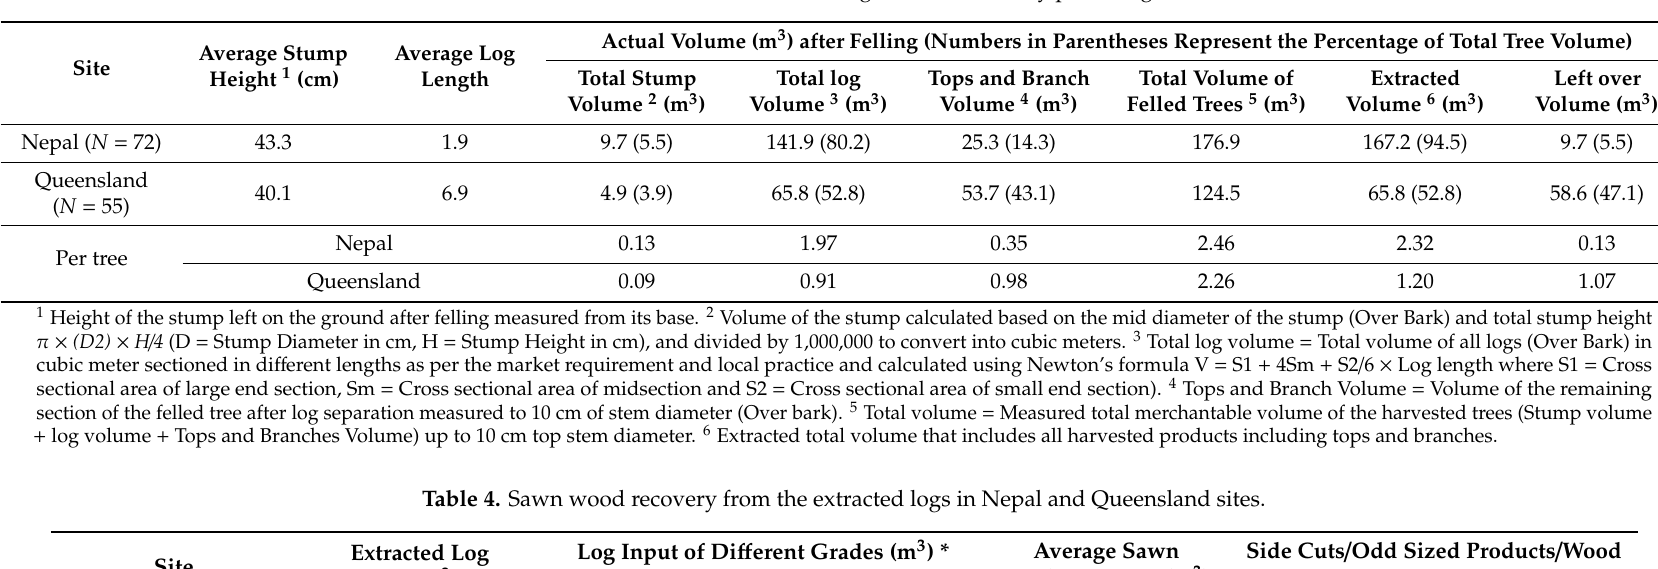
Table 3. Actual volume of the trees after felling and tree recovery percentage at each site.